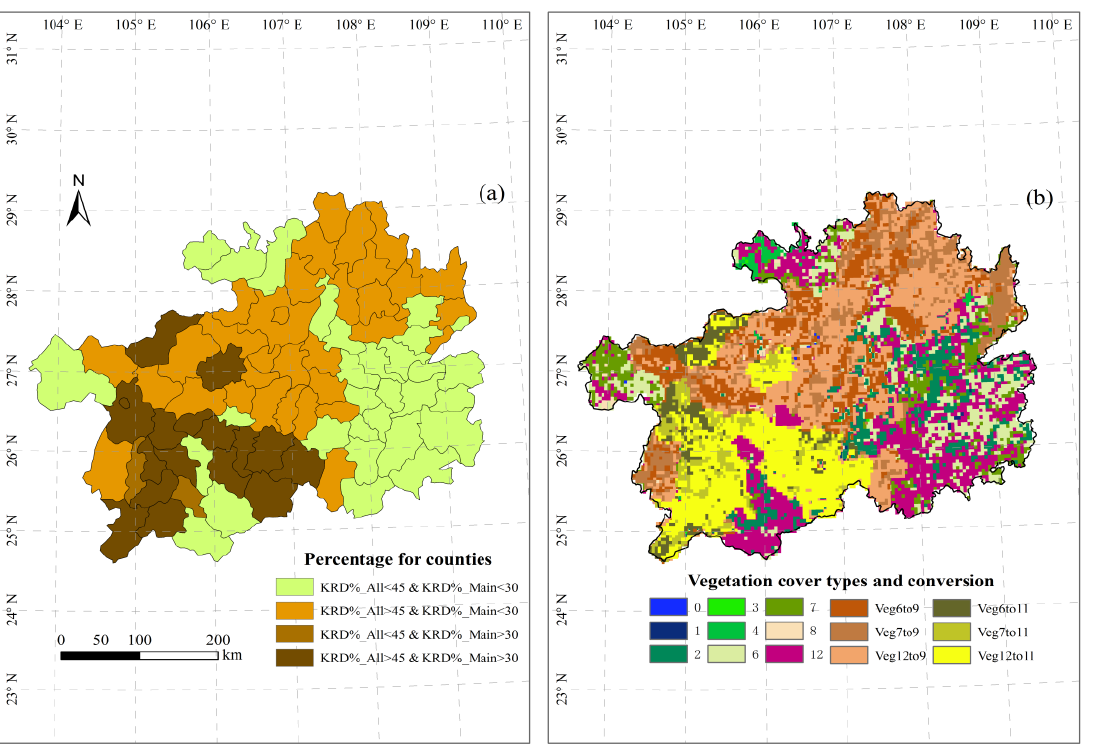
Figure 2. Potential LCC based on the spatial pattern of KRD in GKP. ( a ) The percentage of areas with KRD for counties. KRD%_All: the percentage of total area with potential, light, moderate and severe KRD, KRD%_Main: the percentage same as KRD%_All but excluding potential KRD; ( b ) SSiB vegetation map for GKP and vegetation cover conversion. Vegetation cover classifications are same as Figure 1. Veg6to9: SSiB Type 6 changed to Type 9; Veg7to9: SSiB Type 7 changed to Type 9; Veg12to9: SSiB Type 12 changed to Type 9; Veg6to11: SSiB Type 6 changed to Type 11; Veg7to11: SSiB Type 7 changed to Type 11; Veg12to11: SSiB Type 12 changed to Type